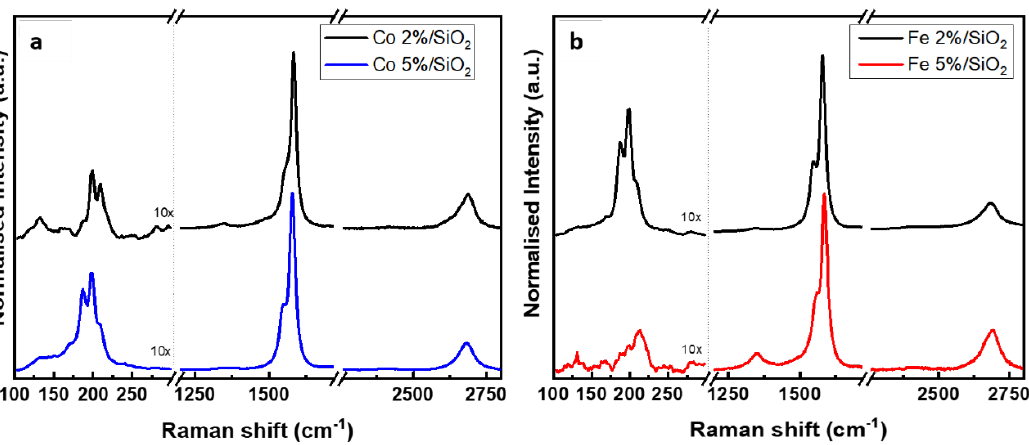
Figure 7. Raman spectra of CNT bundles grown using ( a ) Co and ( b ) Fe catalyst on SiO 2 surface. Table 4. D band to G band ratios for CNT bundles grown over Fe- and Co-based silica substrates. Sample